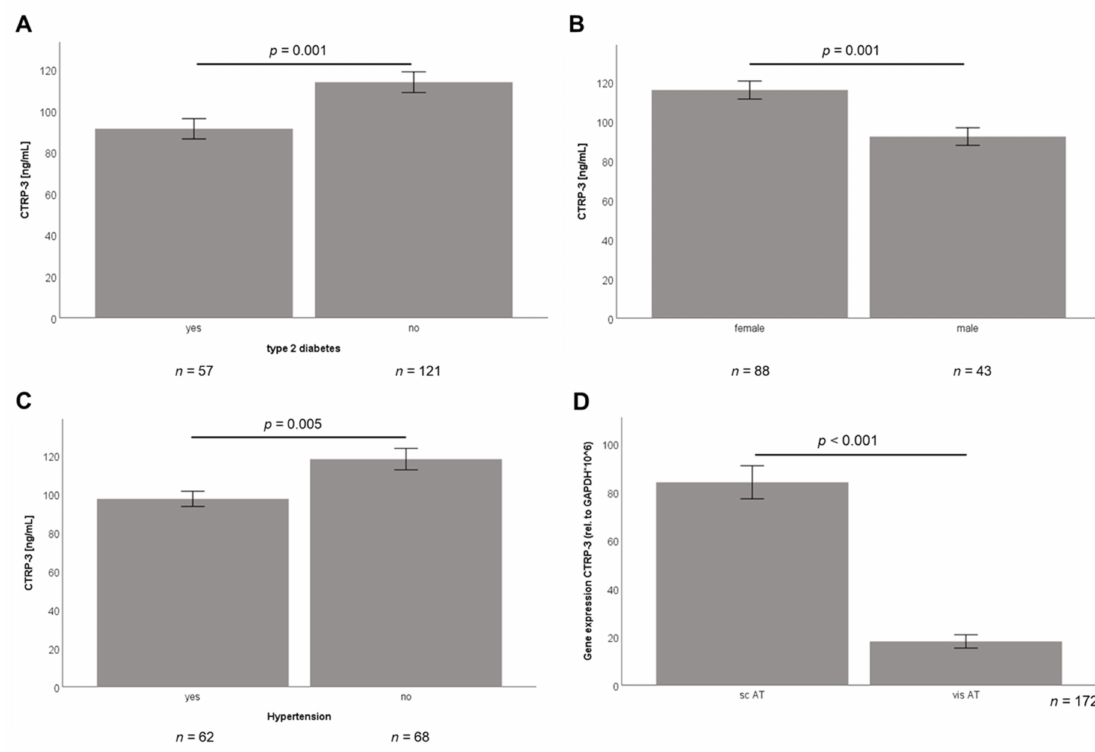
Figure 1. Baseline serum C1q / TNF-related protein-3 (CTRP-3) concentrations in patient cohorts of bariatric surgery and low-calorie formula diet. CTRP-3 serum concentrations were measured by ELISA. AT, adipose tissue; BS, bariatric surgery; GAPDH, glyceraldehyde-3-phosphate dehydrogenase; LCD, low-calorie formula diet; sc, subcutaneous; vis, visceral. ( A ) CTRP-3 serum levels are decreased in BS patients with diagnosed type 2 diabetes. ( B ) CTRP-3 serum levels are higher in females when compared to male patients within the LCD cohort. ( C ) CTRP-3 serum levels are lower in LCD patients with hypertension. ( D ) CTRP-3 expression is significantly higher in subcutaneous adipose tissue when compared to visceral adipose tissue in BS